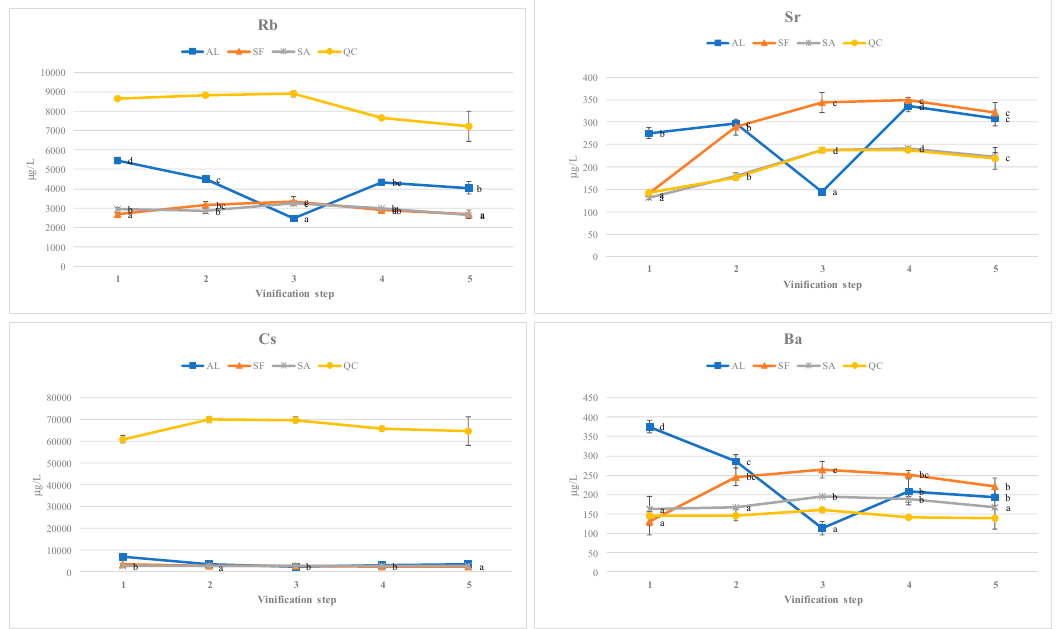
Figure 4. Evolution of alkaline and alkaline earth metals concentrations over vinification, by vineyard of origin. (AL) Vinha de Algeruz; (SF) Quinta de S. Francisco; (SA) Quinta do Sanguinhal; (QC) Quinta dos Carvalhais. Vinification step: (1) after crushing and vatting; (2) after must corrections and inoculation; (3) during the alcoholic fermentation (density approximately of 1030 g/L); (4) after running off; (5) after malolactic fermentation and first racking, before any blending to preserve the trace to the vineyard of origin. For each element and vineyard, results correspond to mean values (and corresponding standard deviations) of three replicates and corresponding analytical duplicates ( n = 6). Means followed by the same letter are not significantly different at 0.05 level of significance. Whenever values are not followed by significance letters it means that a non-parametric parametric test (Kruskal-Wallis test) was applied and comparison of means was not carried out.